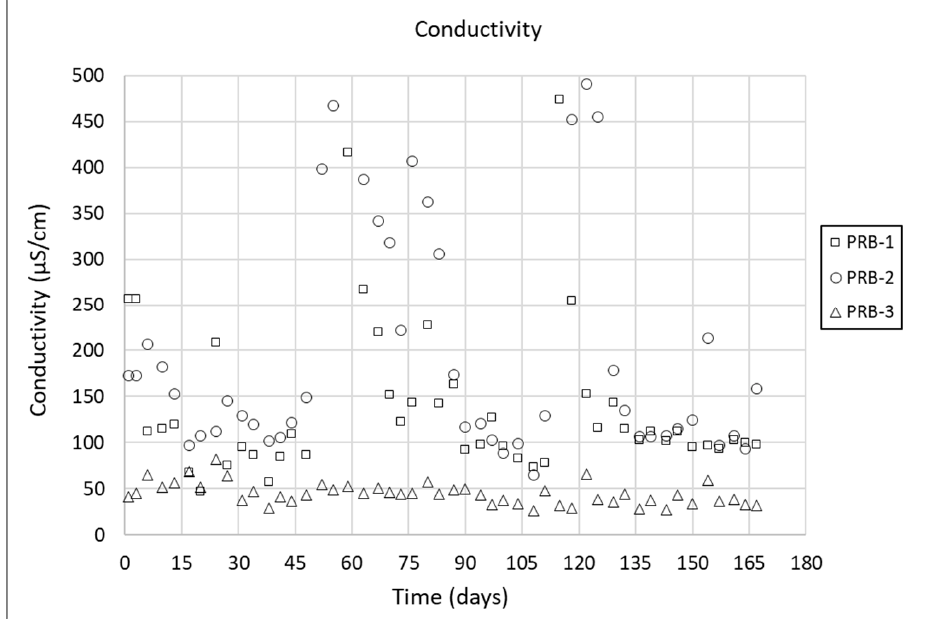
Figure 6. Changes in conductivity in PRB column reactors.